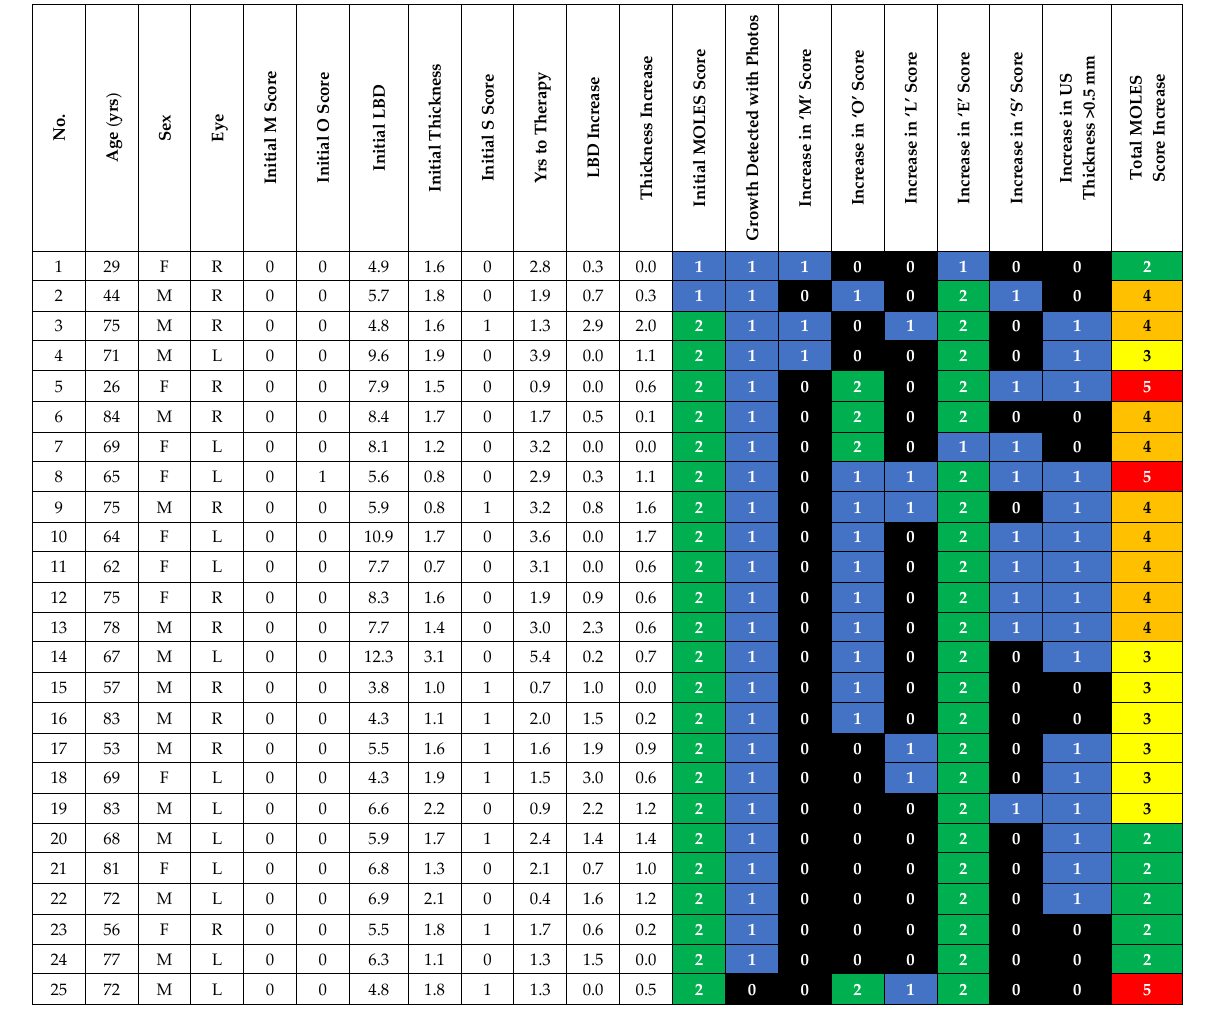
Figure 1. Demographic, baseline and progression details of MOLES 1/2 cases.